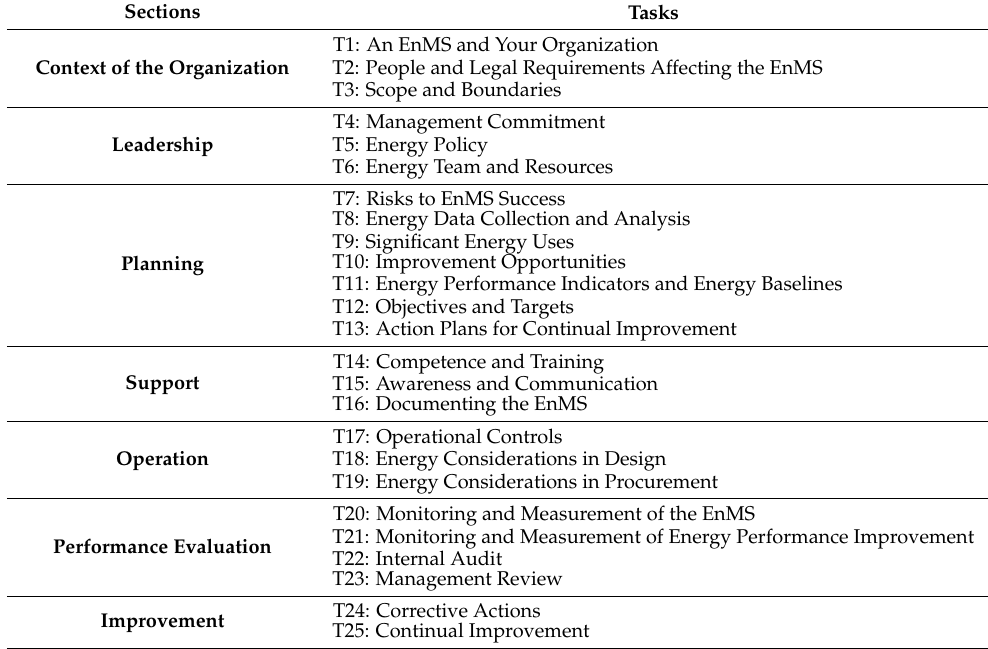
Table 1. The 25 tasks of 50001 Ready Navigator